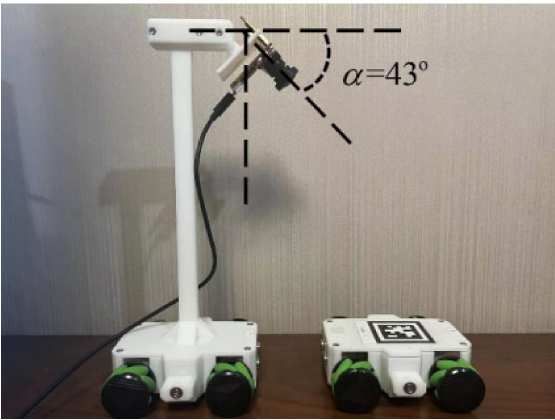
Figure 13. OpenMv on the main control vehicle detects AprilTag.